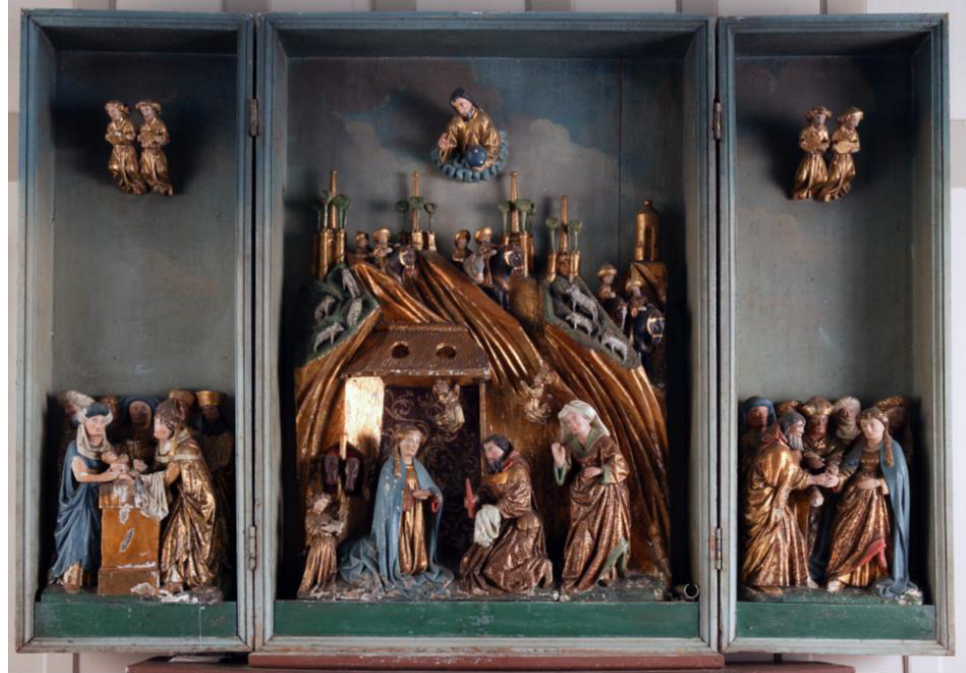
Figure 3. The altarpiece at Skarð church on Skarðsströnd (© National Museum of Iceland).